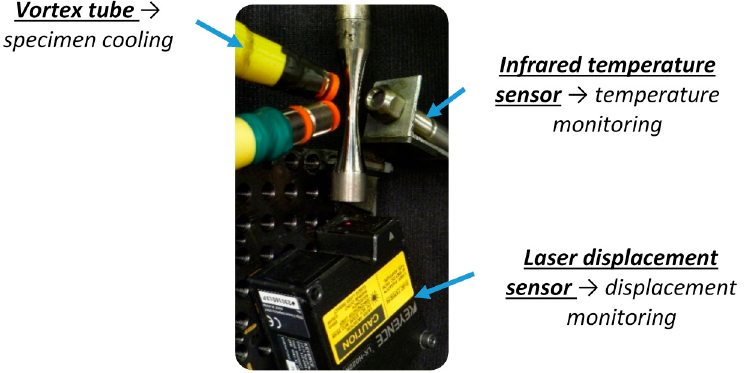
Figure 2. Typical ultrasonic Very High Cycle Fatigue (VHCF) testing configuration.